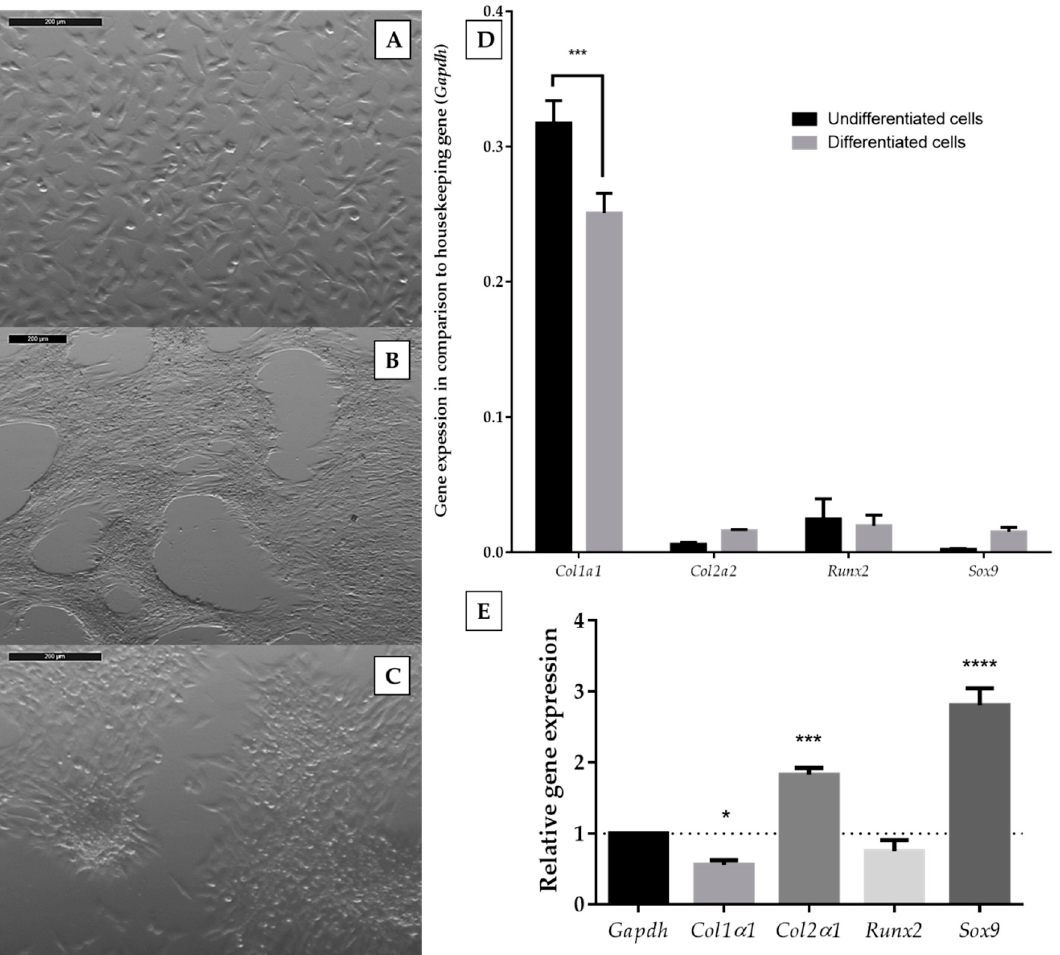
Figure 1. Morphology of ATDC5 cells grown for 14 days in standard growth medium ( A ) or in differentiation medium ( B,C ). The images were captured with a Leica 205C microscope and processed with the Leica Application Suite. The scale bar represents the length of 200 µm; expression levels of chondrocyte-specific genes in undifferentiated and differentiated ATDC5 cells in comparison to a Gapdh housekeeping gene ( D ), and relative gene expression calculated with Livak’s method [24] ( E ). Data represent the means ± standard error of the mean (SEM) from at least three independent experiments. Changes of genes expression between undifferentiated and differentiated cells for different genes were analyzed with two-way ANOVA with Tukey’s comparison test (D). Statistical difference between the control of a Gapdh housekeeping gene and tested genes were analyzed with one-way ANOVA (E). p < 0.05 (*), p < 0.001 (***), and p < 0.0001 (****) for gene expression significantly different from undifferentiated control cells.